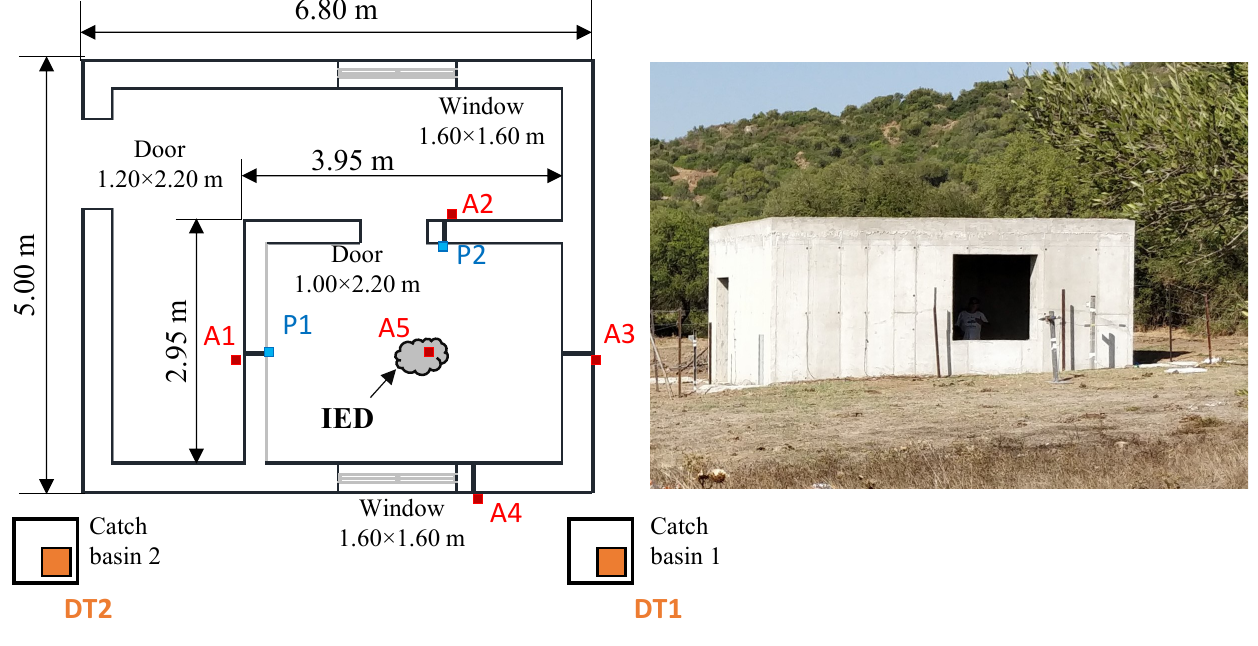
Figure 1. Details of the structure, location of the measuring equipment and photograph of the structure. The letters P refer to pressure sensors, the letters A are accelerometers, and the DTs are Datatrap II recording equipment. Table 1. Load characteristics during the tests carried